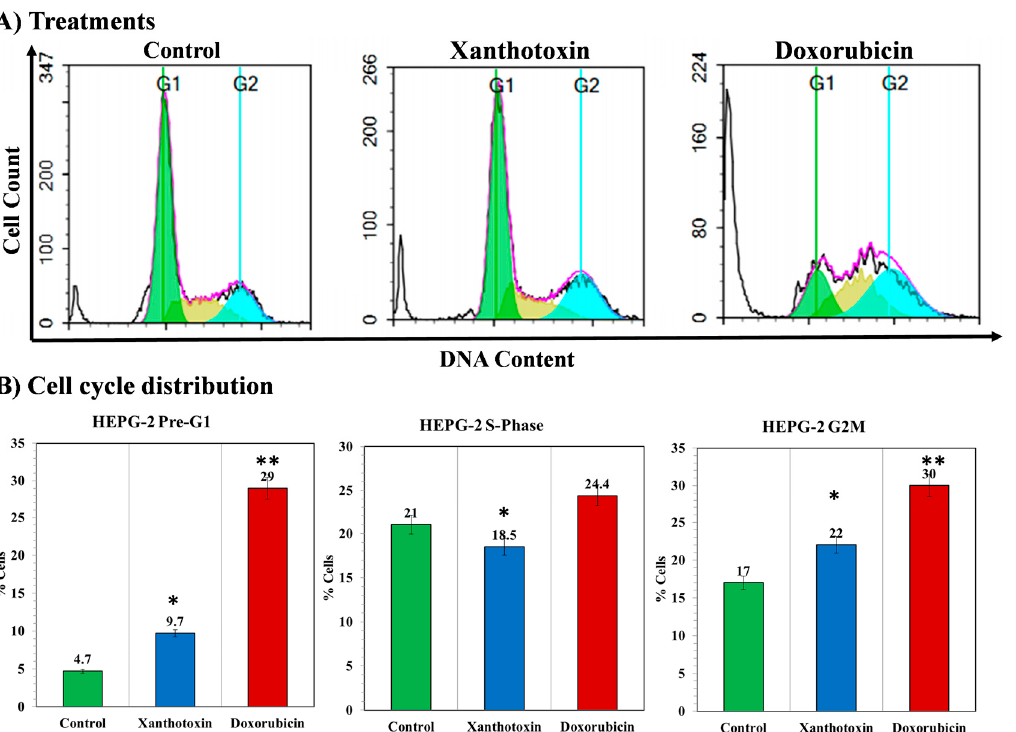
Figure 4. A graphical representation of cell cycle analysis of the HepG2 cells seeded at 2 × 10 3 cells for 48 h in complete DMEM after different treatments. ( A ) Flow cytometric histograms representing the cell cycle phases after treatment with xanthotoxin against HepG2 and doxorubicin at their IC 50 values compared with control cells. ( B ) Diagrams of the percentage of pre-G1 phase, S-phase, and G2/M phases for xanthotoxin and doxorubicin in comparison with control cells. All determinations were carried out in triplicates, and values are expressed as means ± SEM. *, ** denote significant difference at p < 0.05 and p < 0.01, respectively.